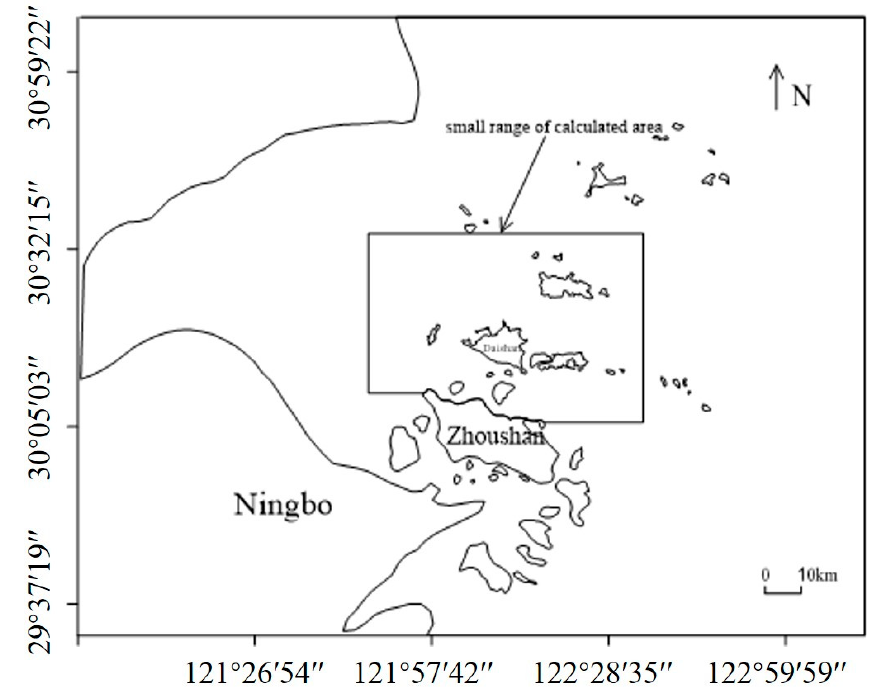
Figure 11. The large and small range of calculated area with mathematical model.